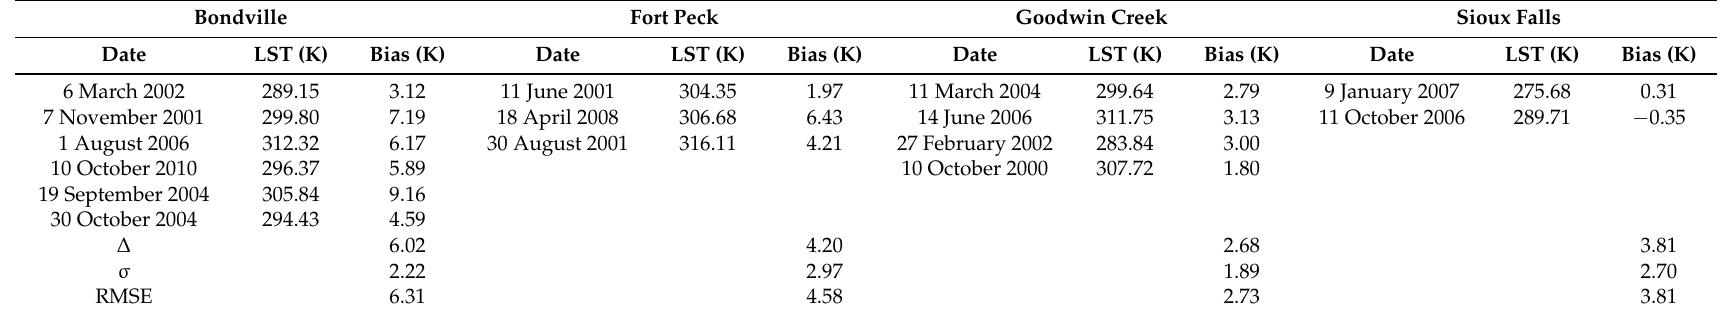
Table 12. Comparison of LST values derived from the SURFRAD stations and the LST inverted by the SCA using band 14 of the ASTER instrument. Bondville Fort Peck Goodwin Creek Sioux